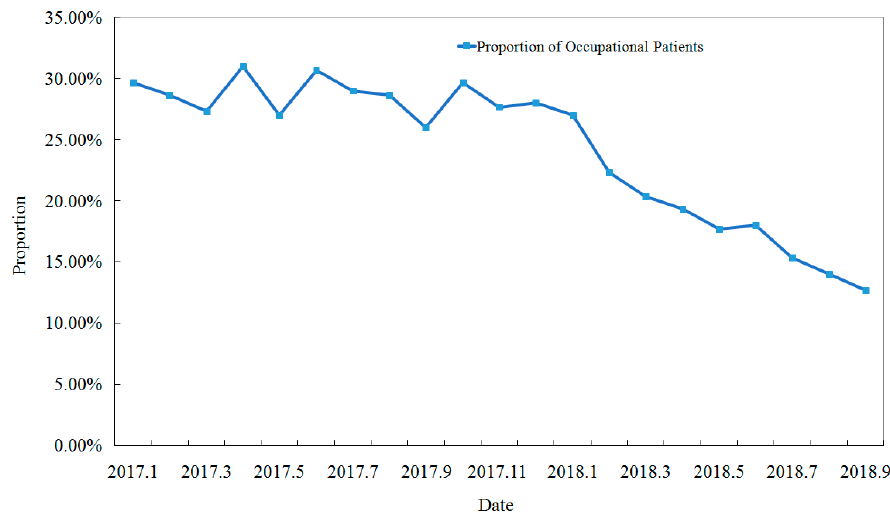
Figure 12. Trends in the proportion of occupational patients in Hongxing Company from January 2017 to September 2018.